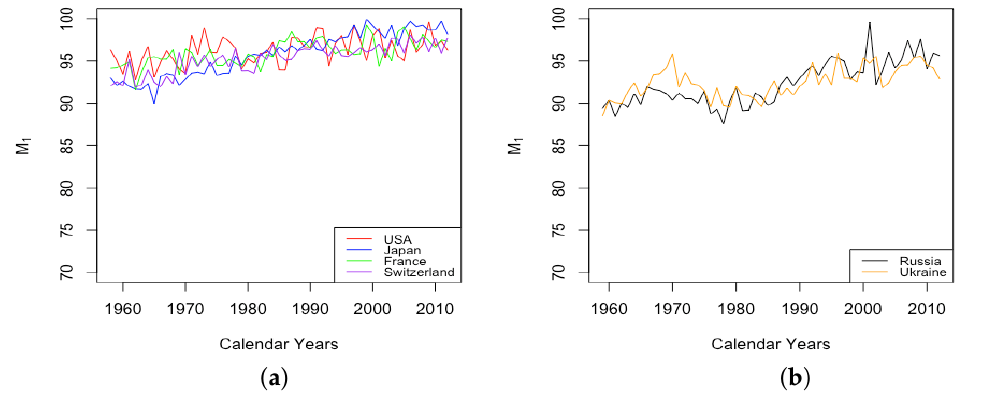
Figure 9. ( a ) Age M 1 of fastest increase in senescent mortality across HLE countries. ( b ) Age M 1 of fastest increase in senescent mortality across ILE